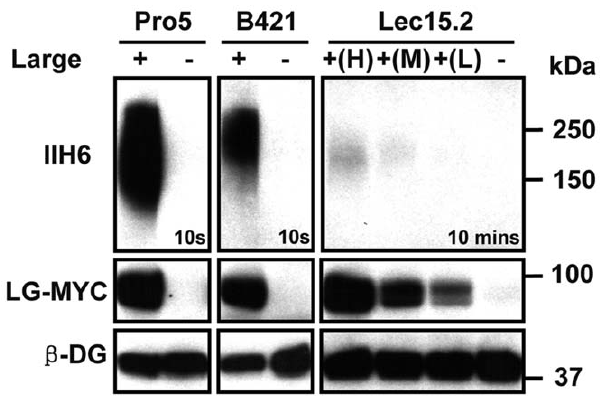
Figure 2. Stable overexpression levels of Large on glycosyla- tion of a -DG in the Lec15 cells. Pro-5, B421 clones overexpressing ( + ) or without ( 2 ) Large-MYC or Lec15.2 cells overexpressing Large-MYC at high + (H), modest + (M) low + (L) or without Large-MYC ( 2 ) were tested by immuno-blot assay. The blot of the Lec15.2 samples had 10 mins exposure, while all other blot had about 10 seconds’ exposure time.